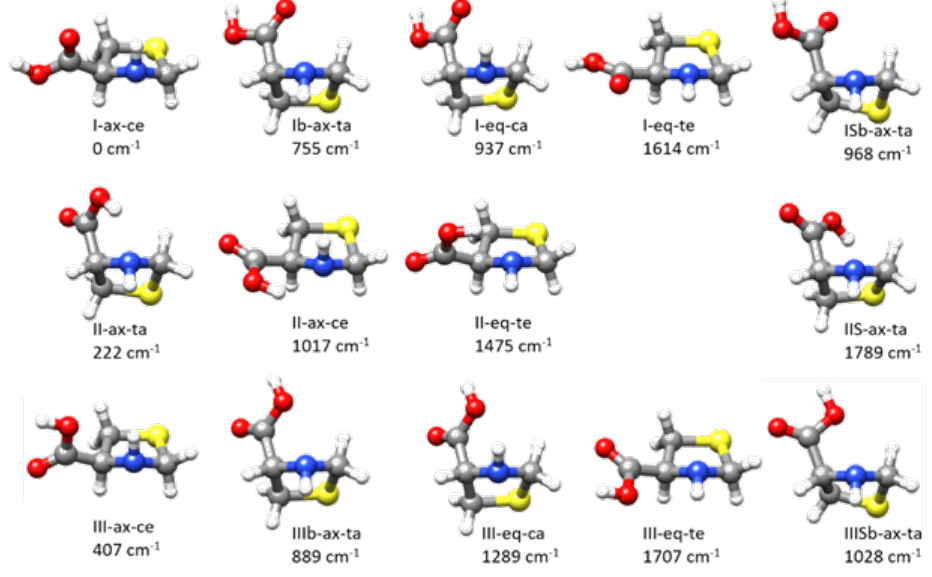
Figure 1. The different conformers found for thioproline from exploration of the potential energy surface. The labeling is described in the text. The quoted relative energies were calculated at the B3LYP-D3/6-311++G(2d,p) level (see Figure S2 for other